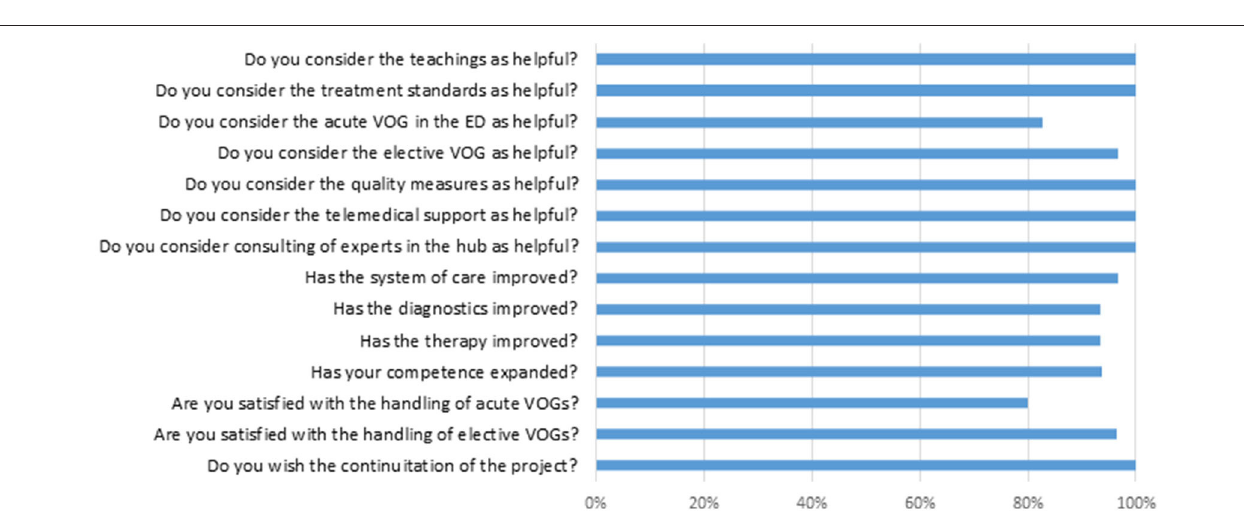
FIGURE 6 | Results of online survey in November 2020. Rates of positive